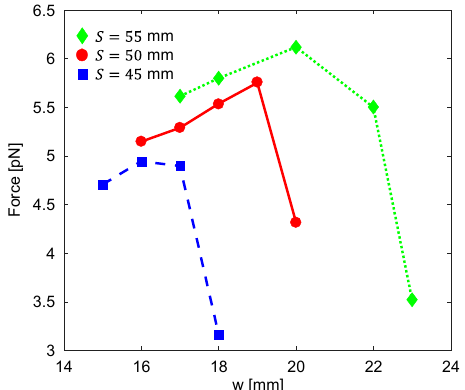
Figure 9. The magnetic force acting on a magnetic particle located at 𝑧 = 2 mm from an electromagnet with a parabolic pole tip as a function of the electromagnet’s winding area width. For a fixed total diameter of the electromagnet, 𝑆 , the magnetic force is maximized by using the optimal combination of 𝐷 , the pole’s diameter, and 𝑤 , the winding area width. The core sleeve’s width is assumed to be 3 mm.